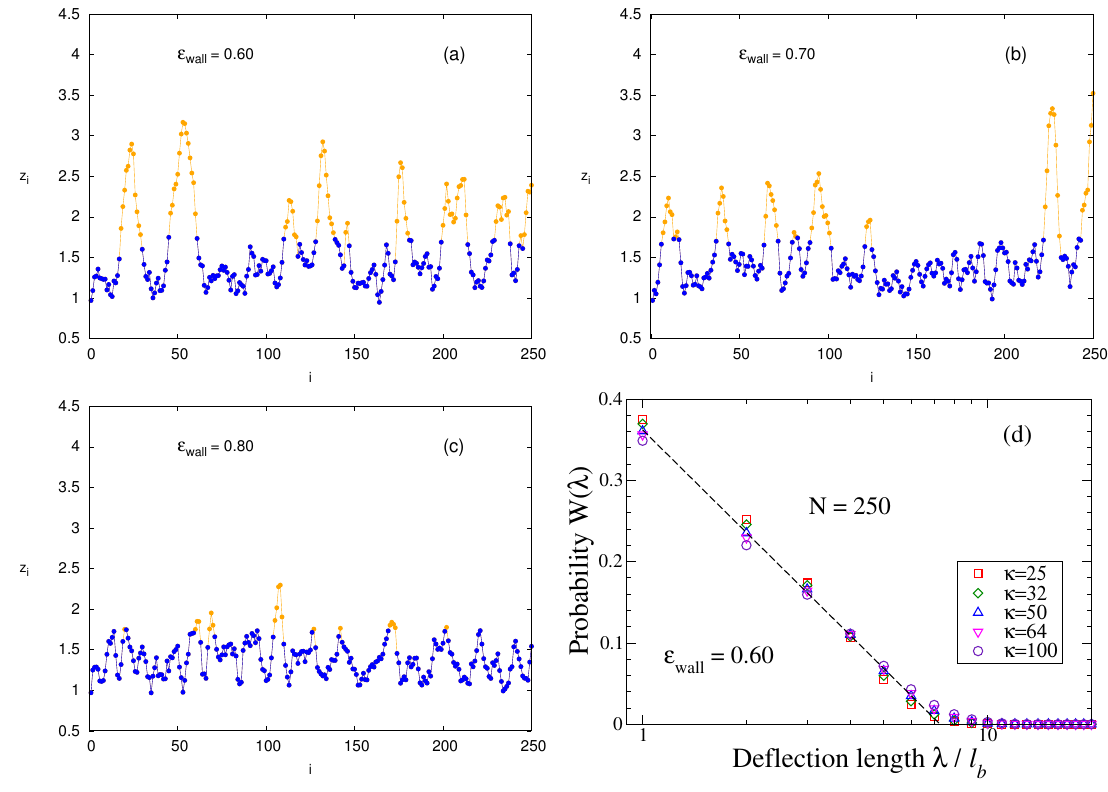
Figure 4. Conformations of strongly adsorbed chains ( N = 250, κ = 25) showing the z coordinate z i of the monomers plotted vs. their index i labeling them along the chain contour. Three choices of (cid:101) wall are shown: (cid:101) wall = 0.60 ( a ); 0.70 ( b ); and 0.80 ( c ). Monomers in trains are shown in blue, those in loops in yellow. ( d ) probability distribution W ( λ ) plotted vs. deflection length λ for N = 250, (cid:101) wall = 0.60, and five choices of κ , as indicated. The dashed line denotes the function W ( λ ) = 0.18ln λ 0 ≈